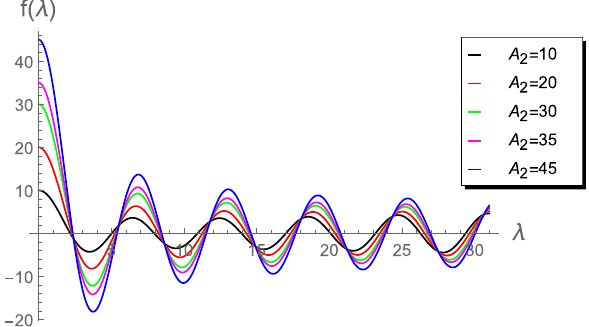
Figure 3. Plot of f ( (cid:31) ) vs (cid:31) for A 2 = { 10, 20, 30, 35, 45 } .